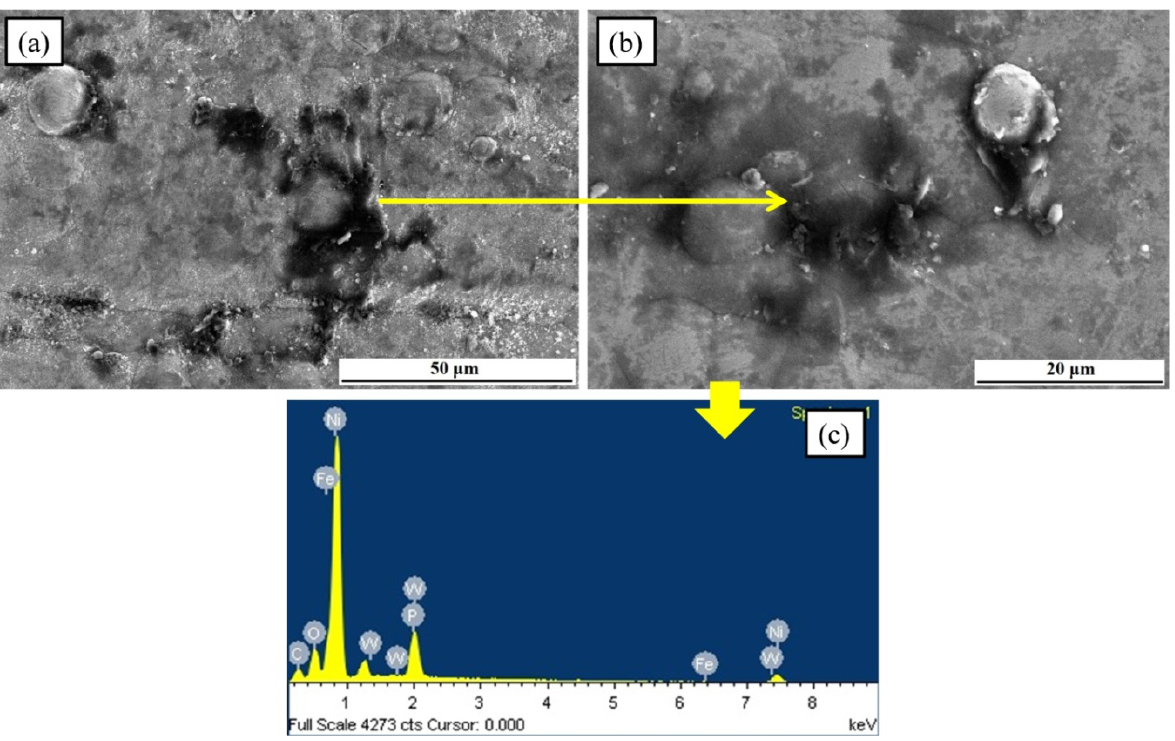
Figure 11. SEM images of (a) corroded bare steel rebar and (b) magnified view of the pit in (a